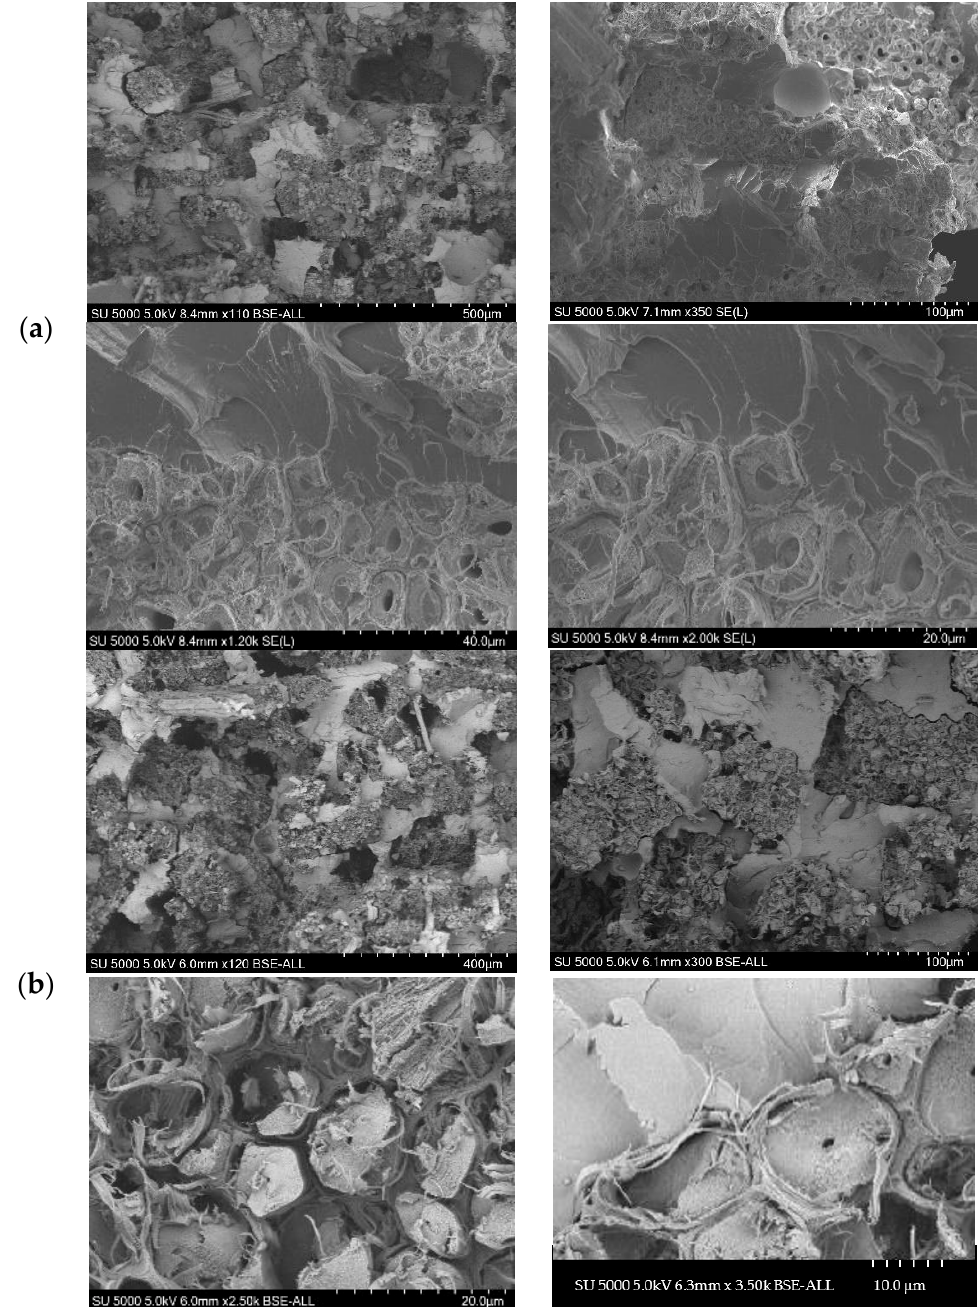
Figure 4. SEM micrographs of fracture surface at four different magnifications. ( a ) Hackled CL fibers and ( b ) non ‐ hackled CL fibers.